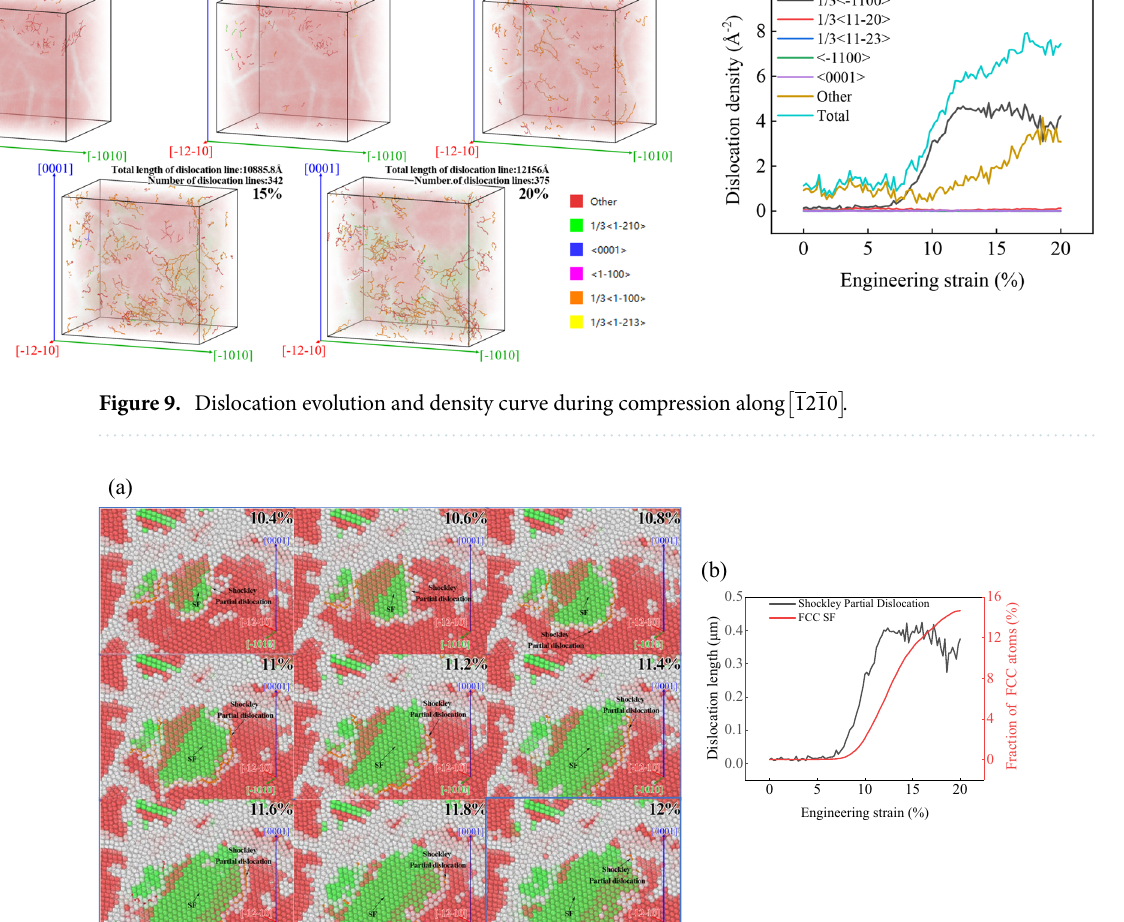
Figure 10. Correlation between Shockley partial dislocations and FCC